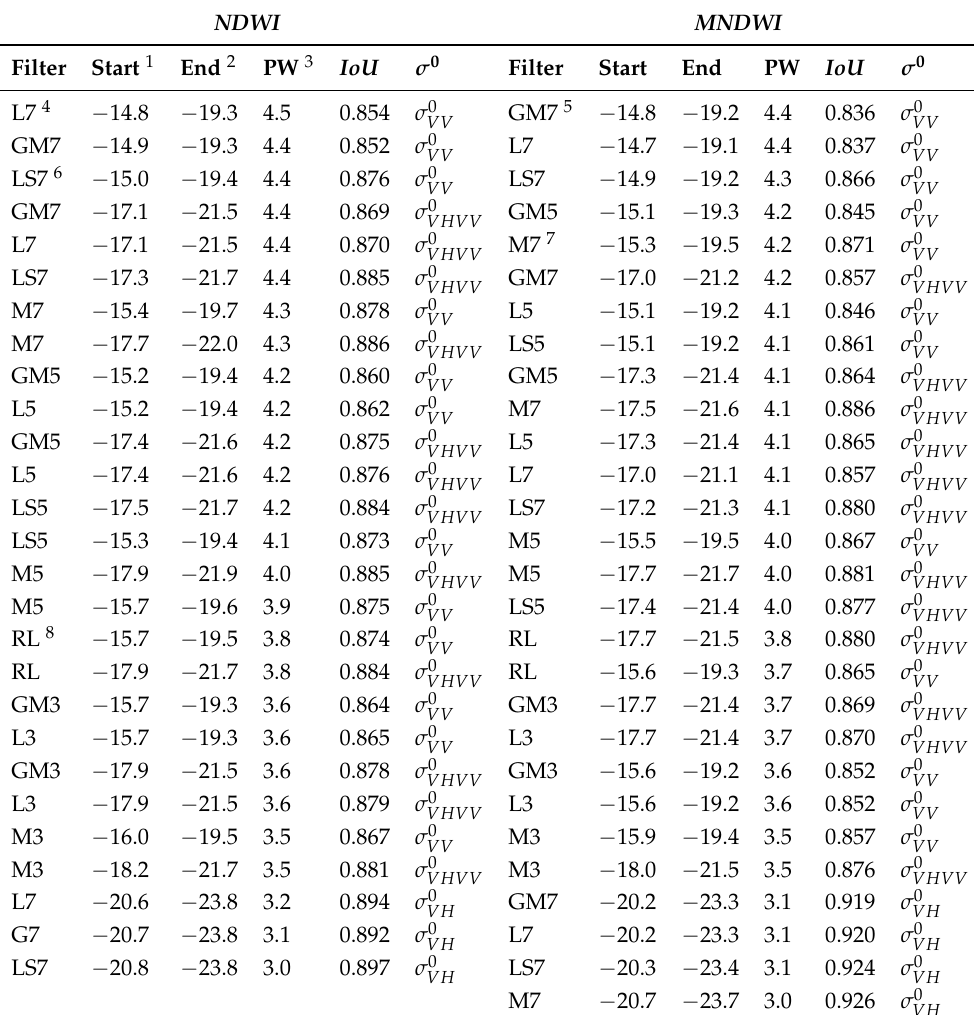
Table 3. Quantitative plateau characteristics for all filters, polarization, and reference